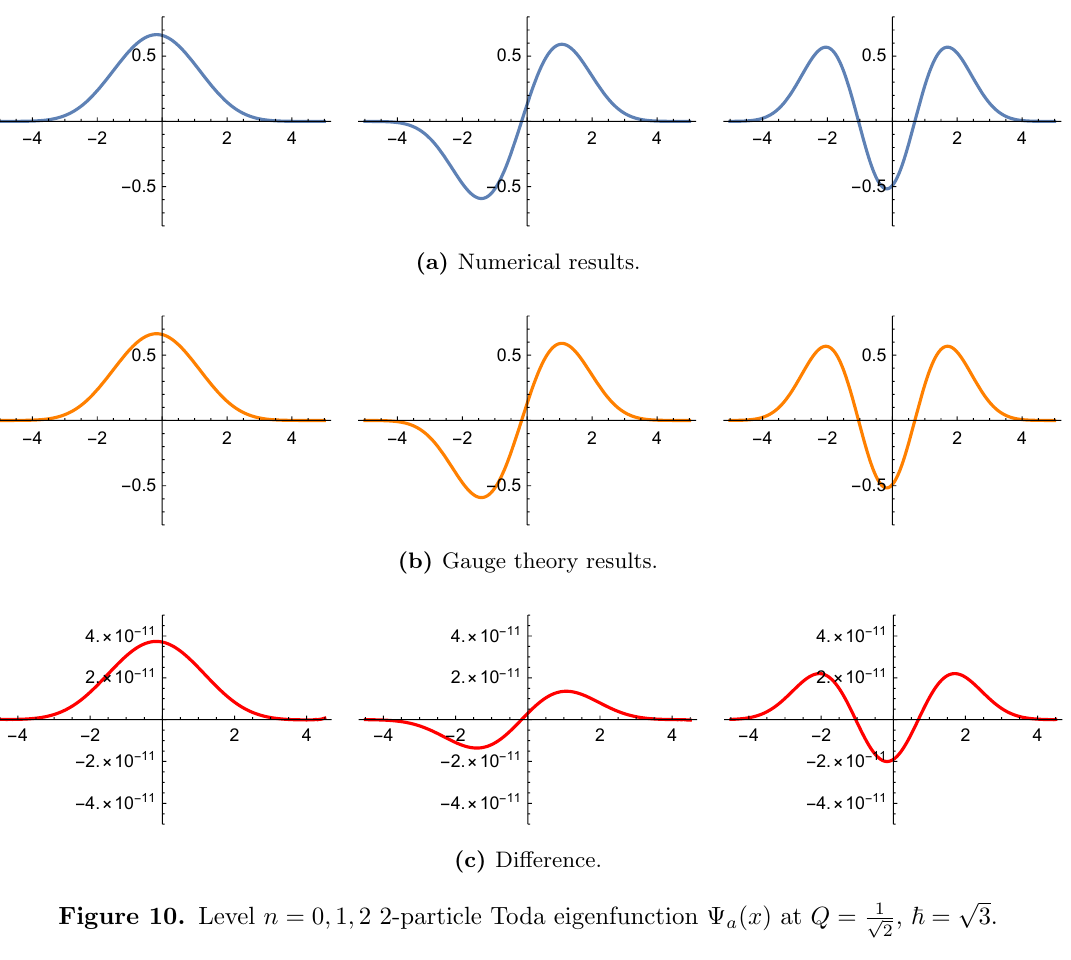
Figure 10. Level n = 0 ; 1 ; 2 2-particle Toda eigenfunction (cid:9) a ( x ) at Q = 1 p